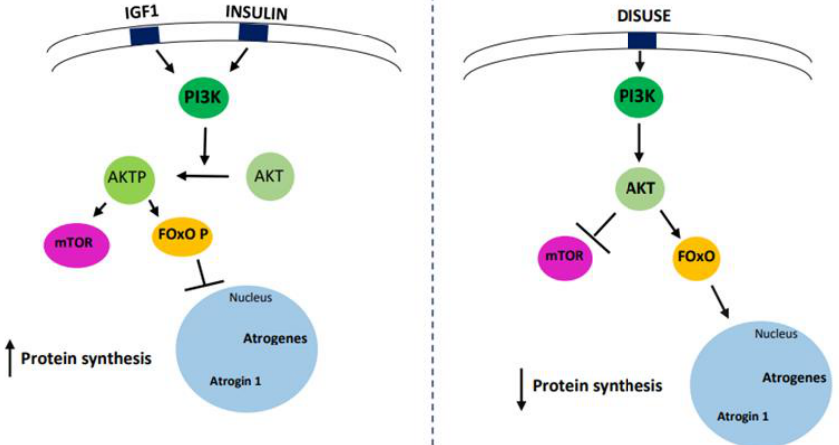
Figure 4. Insulin and IGF1 activate the PI3K-AKT-mTOR pathway, resulting in protein synthesis and hypertrophy. On the other hand, disuse condition leads to a blockage of the AKT signaling pathway. The arrows indicates an increase of protein synthesis in normal condition or a reduction of protein synthesis during disuse.